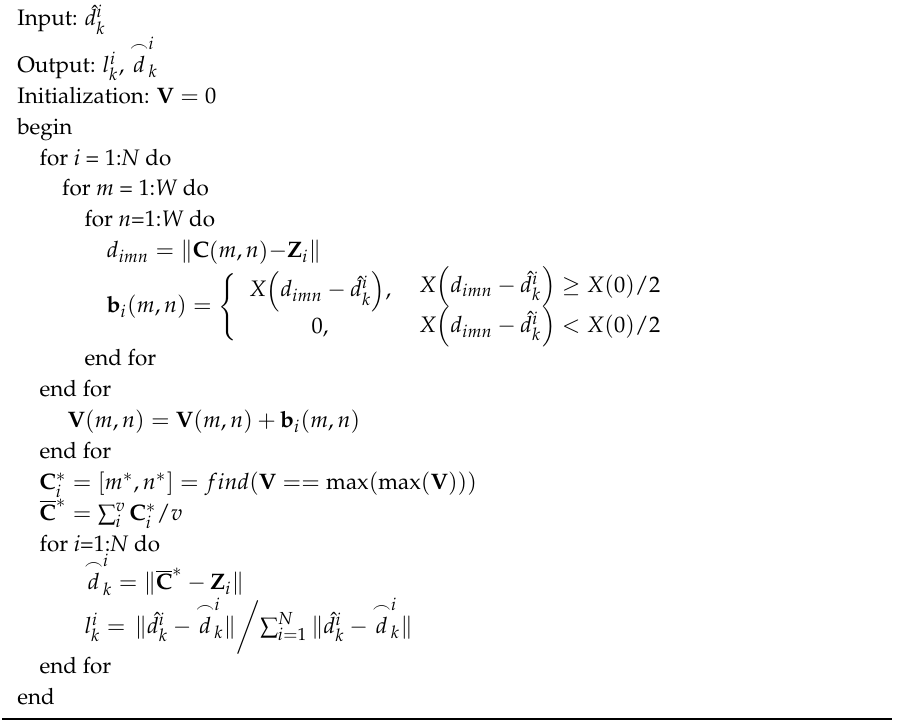
Algorithm 1 Condition detection and distance correction based on hierarchical